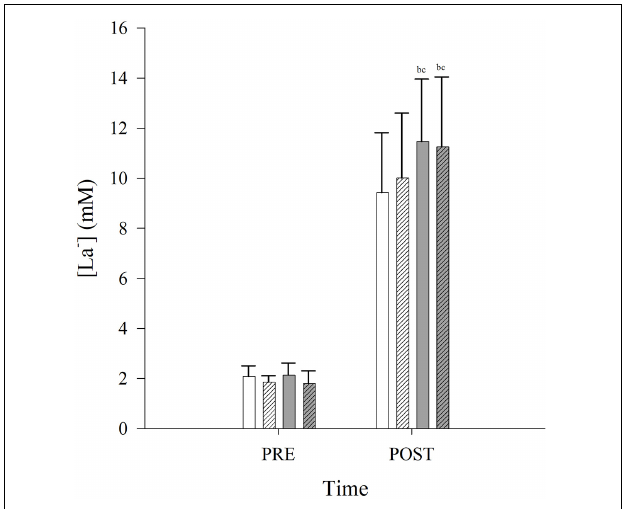
FIGURE 4 | Arterialized capillary lactate concentrations ([La − ]) PRE and POST exercise in CONLD (white), CONLD-BH (white with diagonal lines), FLK (gray) and FLK-BH (gray with diagonal lines). All four POST [La − ] were greater than the PRE [La − ]. a Significantly greater than CONLD. b Significantly greater than POST CONLD. c Significantly greater than POST